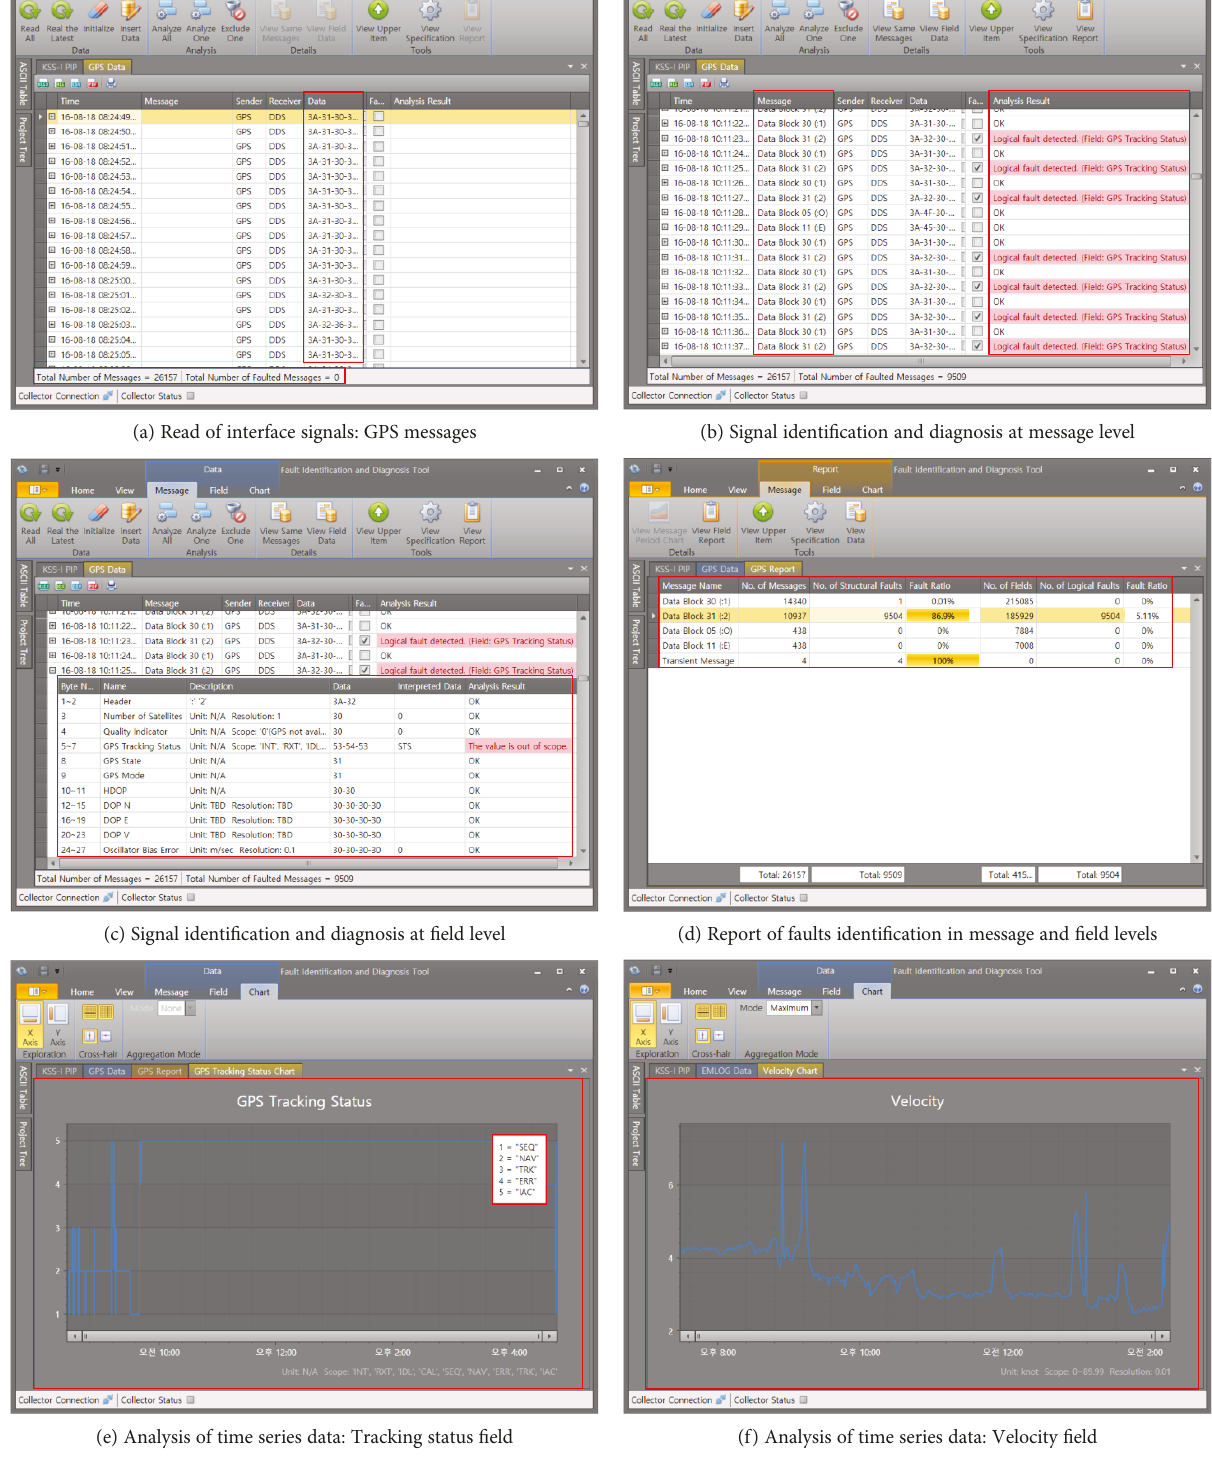
Figure 9: Results of fault detection and diagnosis using developed